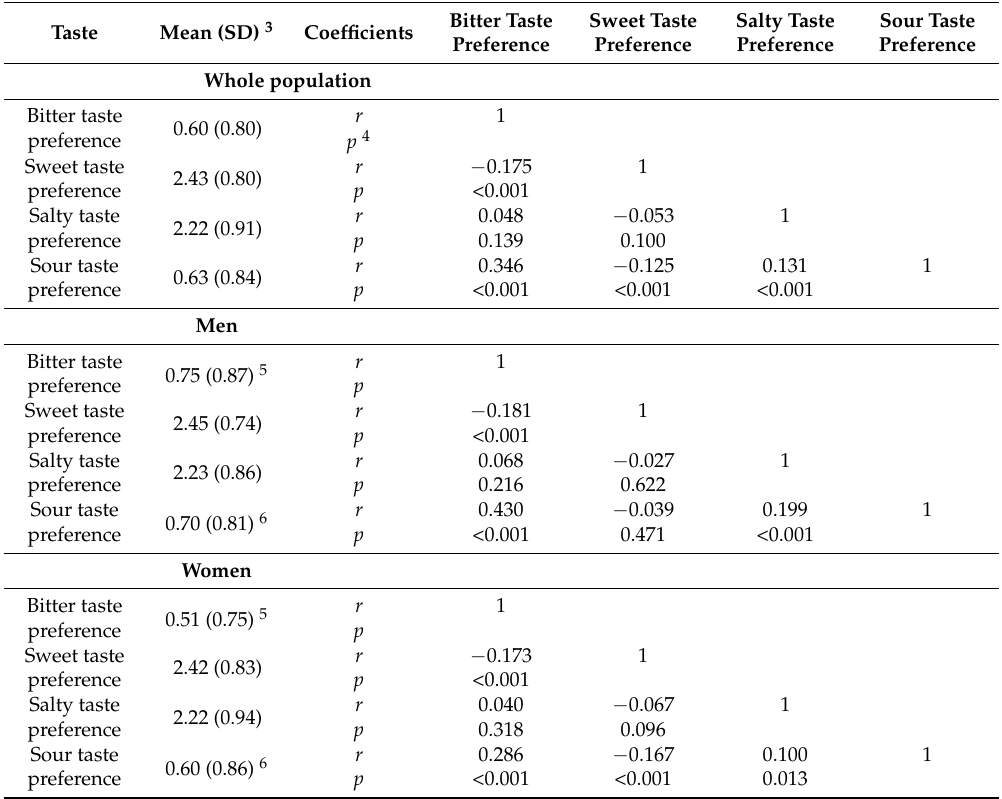
Table 5. Association between the preference of different tastes 1 in the whole population 2 and by